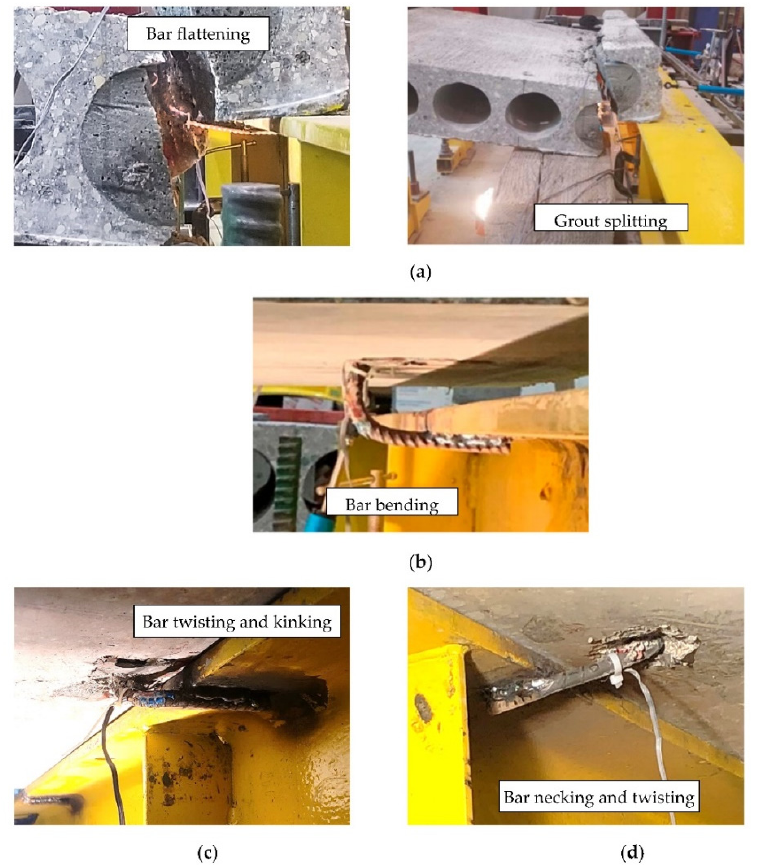
Figure 8. Mode of failure for side-bearing specimens: ( a ) SB-TN-90 (pulling/normal), ( b ) SB-CN-90 (pushing/normal), ( c ) SB-CP-90 (pushing/parallel), and ( d ) SB-TP-90 (pulling/parallel).